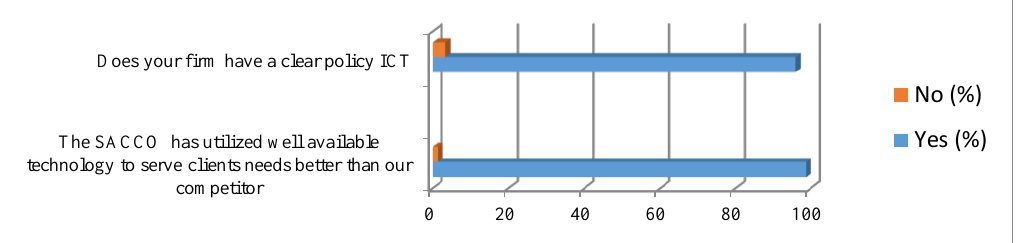
Figure 2: Information, Communication Technology (ICT) policies